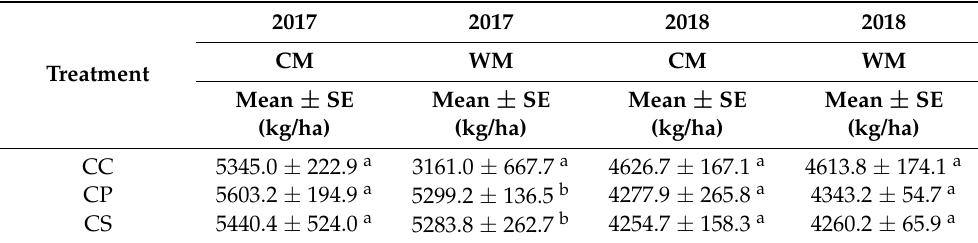
Table 7. Soybean yield in 2017 and 2018 at two field sites, Beltsville [Central Maryland (CM)] and Keedysville [Western Maryland (WM)], across three post-harvest treatments following corn harvest. For the three treatments, CC denotes cover crop planted in corn residue/stubble; CP represents plots that were chisel plowed (conventional tillage); and CS (corn stubble) no